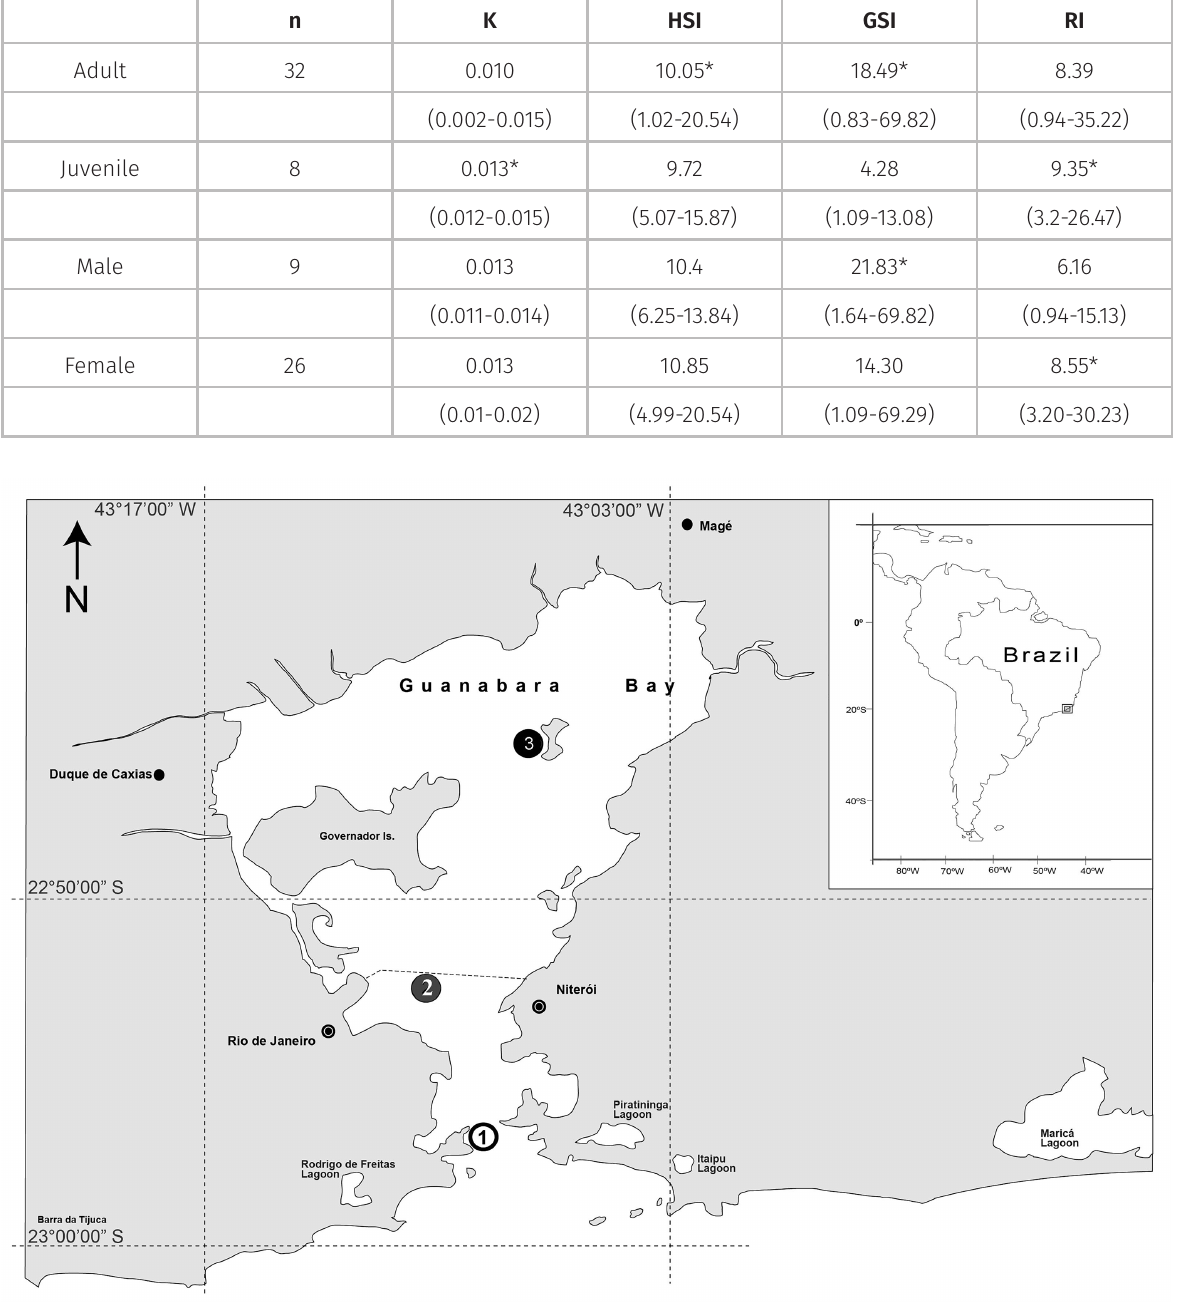
Table II. Mean values and range (between parentheses) of the physiological indexes calculated for Orthopristis ruber caught in Guanabara Bay. K: condition factor; HSI: hepatosomatic index; GSI: gonadosomatic index; and RI: fullness index. *: significant values (p < 0.05).